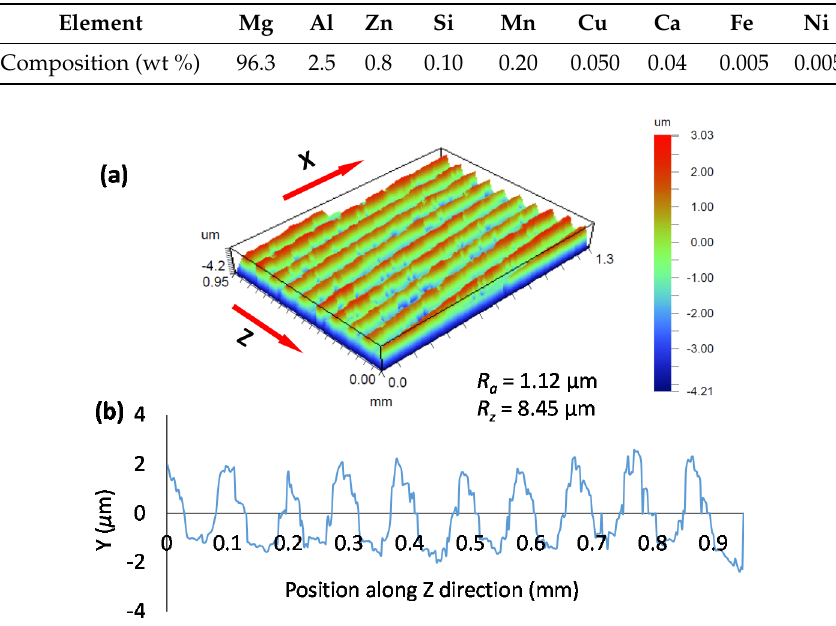
Table 1. Elemental composition of AZ31B alloy used.